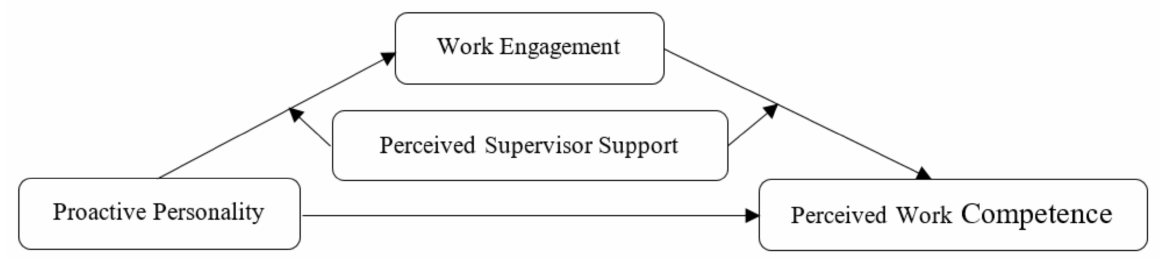
Figure 1. Hypothesized research model in this